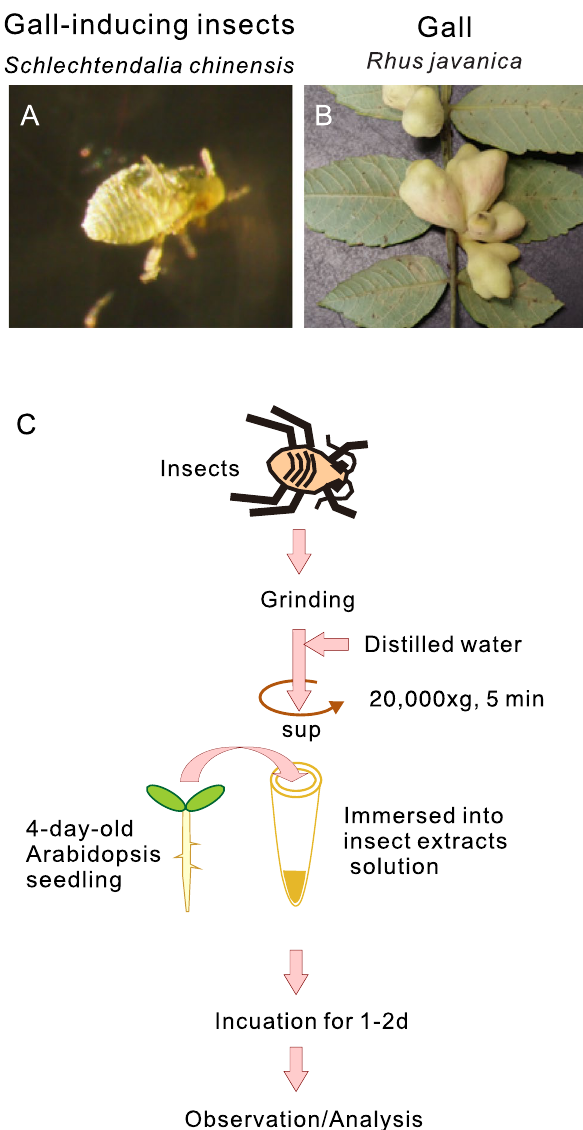
Figure 1. Schematic illustration explaining the use of Ab-GALFA for testing the gall-inducing effect of an aphid, Schlechtendalia chinensis . S. chinensis ( A ) induces large, single-chamber galls ( B ) in Rhus javanica. ( C ) Insect bodies are ground in liquid nitrogen and suspended in sterile distilled water to prepare the insect extract solution. Arabidopsis seedlings incubated in the solution are observed or analyzed via confocal microscopy or RNA